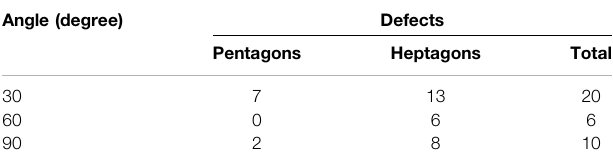
TABLE 2 | Total number of defects of Junctions with different contact angles. Angle (degree) Defects